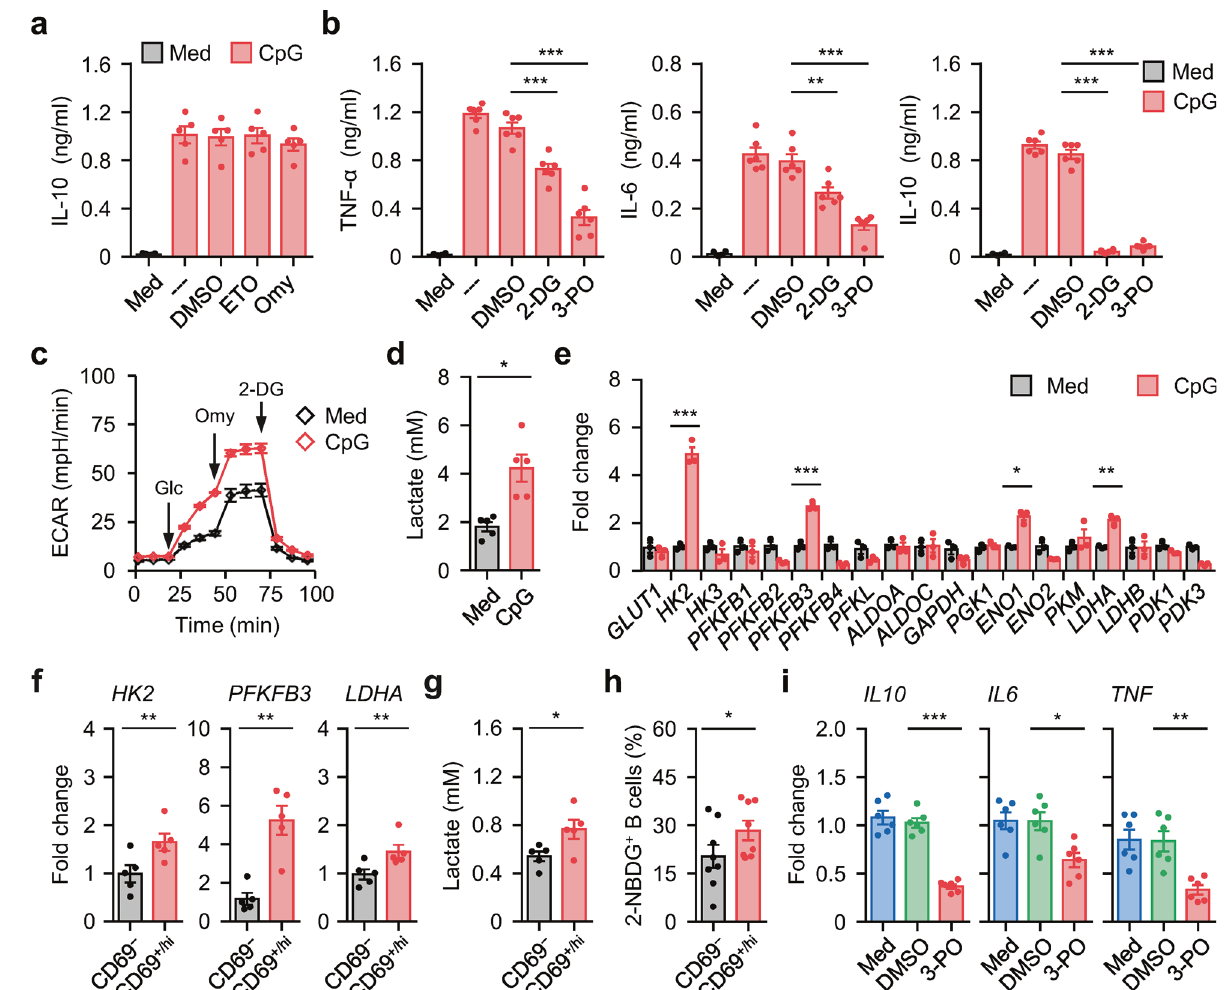
Fig. 4 Metabolic reprogramming involved in in fl ammatory B reg cell induction a , b Total B cells from healthy donors were cultured in medium or pretreated with DMSO, inhibitors against fatty acid oxidation (Etomoxir, ETO) ( a ), oxidative phosphorylation (Oligomycin, Omy) ( a ), or glycolysis (2-DG; 3-PO) ( b ). Thereafter, the cells were incubated in the presence or absence of CPG-DNA. Cytokine production were detected by ELISA ( n = 5 for a ; n = 6 for b ). c – e Total B cells puri fi ed from healthy donors were cultured in medium or treated with CPG-DNA for 3 d. Extracellular acidi fi cation (ECAR) ( c ), accumulated lactate production ( d ), and expression of glycolytic enzymes ( e ) were measured by seahorse analyzer, lactate assay kit, and real-time PCR, respectively ( n = 3 for c and e ; n = 5 for d ). f – h Expression of key rate-limiting glycolytic enzymes ( f ), accumulated lactate production ( g ), and capabilities of glucose incorporation (2-NBDG + ) ( h ) by CD69 − and CD69 + /hi B cells puri fi ed from untreated SLE patients were examined by real-time PCR ( f ), lactate assay kit ( g ), and FACS ( h ), respectively ( n = 5 for f and g ; n = 8 for h ). i Puri fi ed CD69 + /hi B cells from blood of untreated SLE patients were cultured in medium or in the presence of DMSO, or 3-PO for 12 h. Expression of IL10 , IL6 , and TNF were examined by real-time PCR. Data were acquired from more than four independent experiments and shown as means ± SEM. Signi fi cance was determined with one-way ANOVA test ( a , b , i ) or Student ’ s t test ( d – h ). * p < 0.05, ** p < 0.01, *** p < 0.001 Targeting c-Myc-elicited glycolysis abolishes the pathogenic response induced by functional B reg cells Given that functional B reg cells (IL-10 + B cells) were co-polarized in fl ammatory features repurposed B reg cell function away from immune tolerance and toward a pathogenic response. In the blood of SLE patients, most T cells mainly exhibited a CCR7 − CD45RA − effector memory phenotype (Fig. 6a). Analyzing the IL-10 receptor (IL-10R) in T cells from SLE blood revealed that this receptor was primarily expressed by CD8 + but not CD4 +